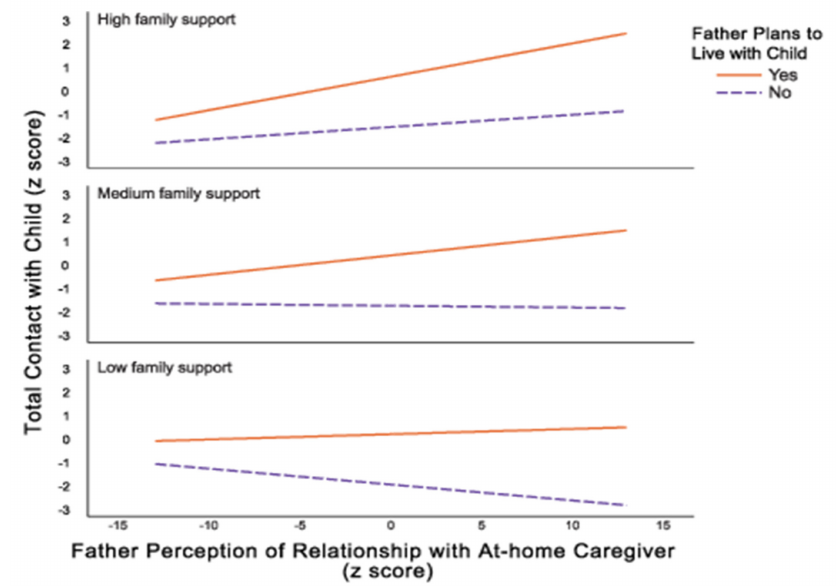
Figure 2. Three-Way Interaction of Family Support, Quality of The Father–Caregiver Relationship, and Paternal Plans to Live with the Focal Child on Father–Child